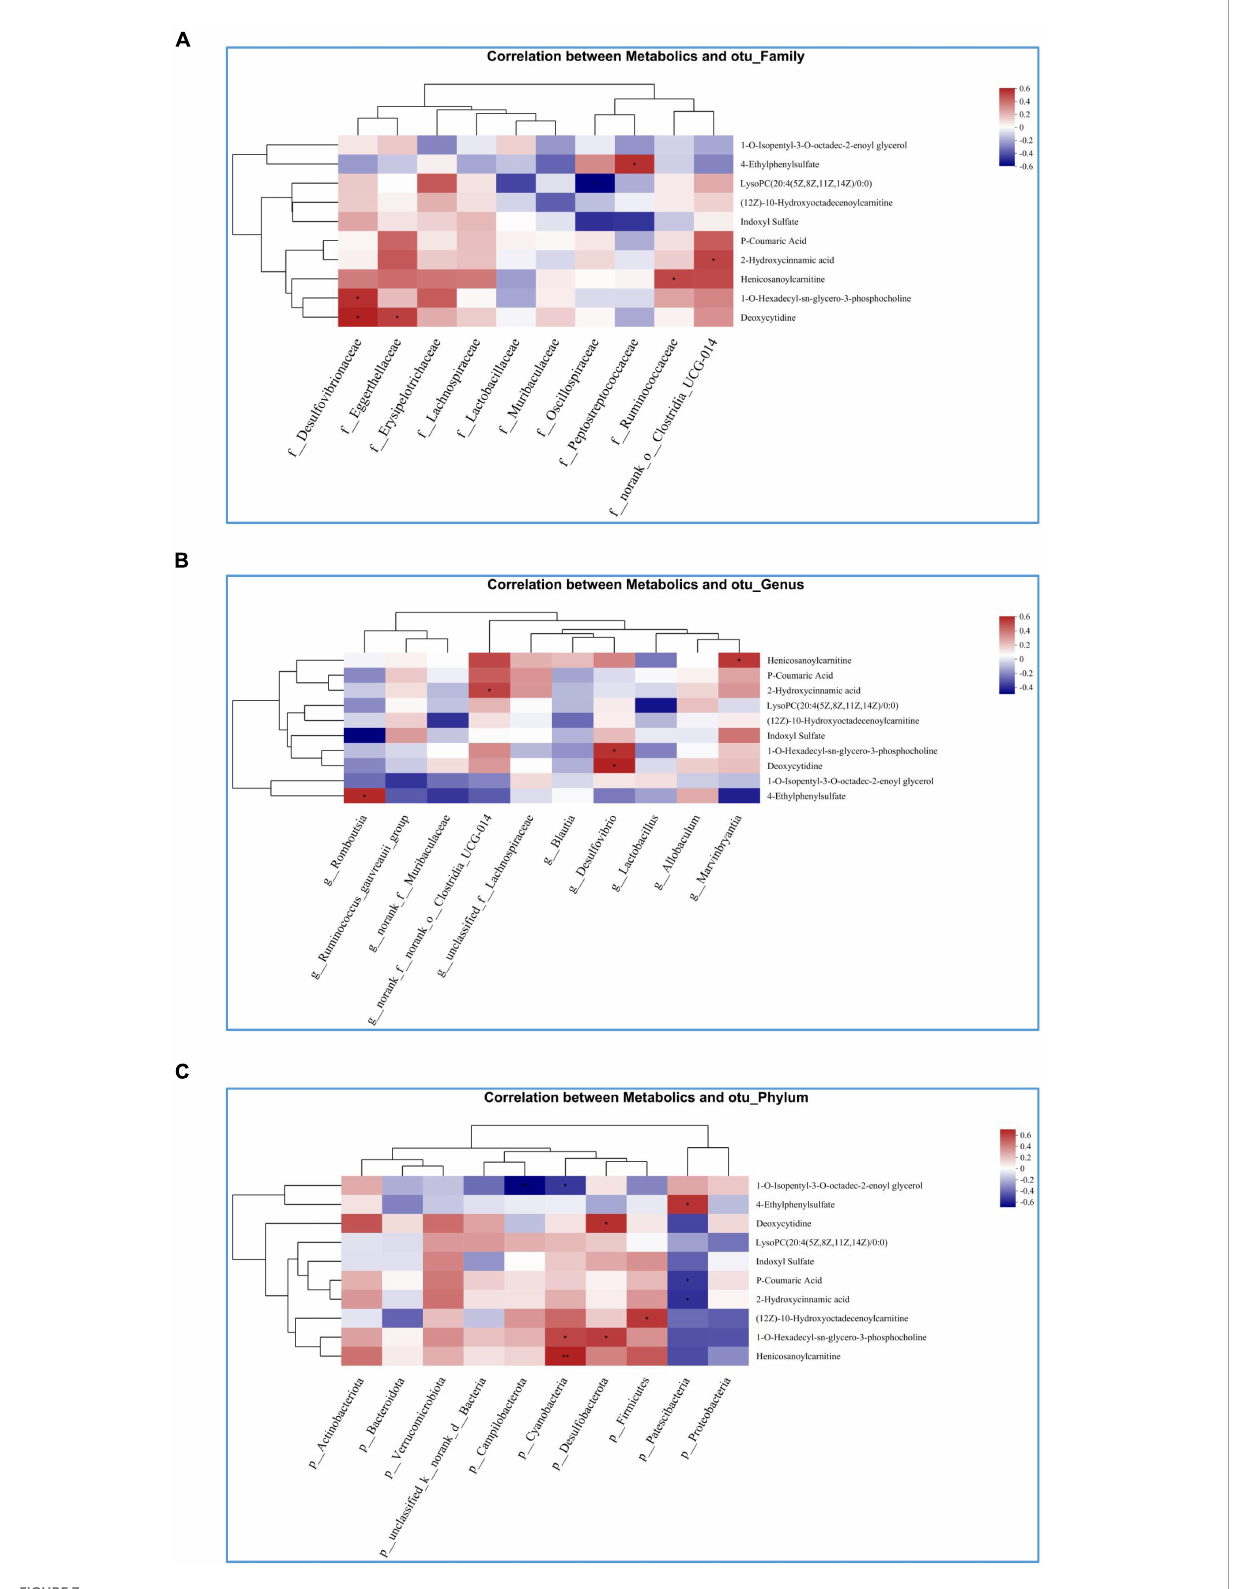
FIGURE7 Heatmap of the correlation analysis between gut microbiota and targeted metabolic profiling. (A) Correlation between intestinal flora and metabolites at the family level; (B) correlation between intestinal flora and metabolites at genus level; (C) correlation between intestinal flora and metabolites at phyla level. *Statistically significant difference ( P < 0.05). **Statistically significant difference ( P <